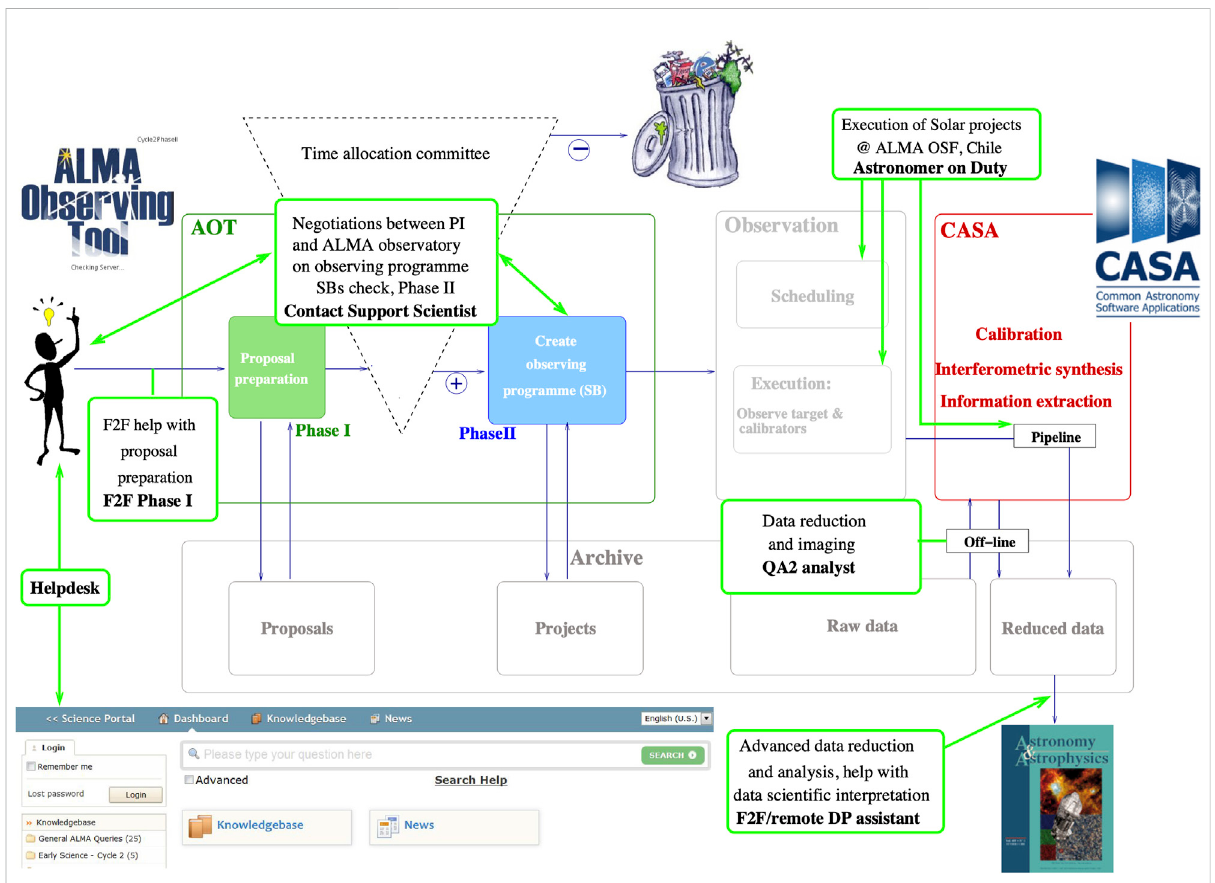
FIGURE 6 Schematic representation of the work fl ow of a project from proposal development and submission to data reduction and